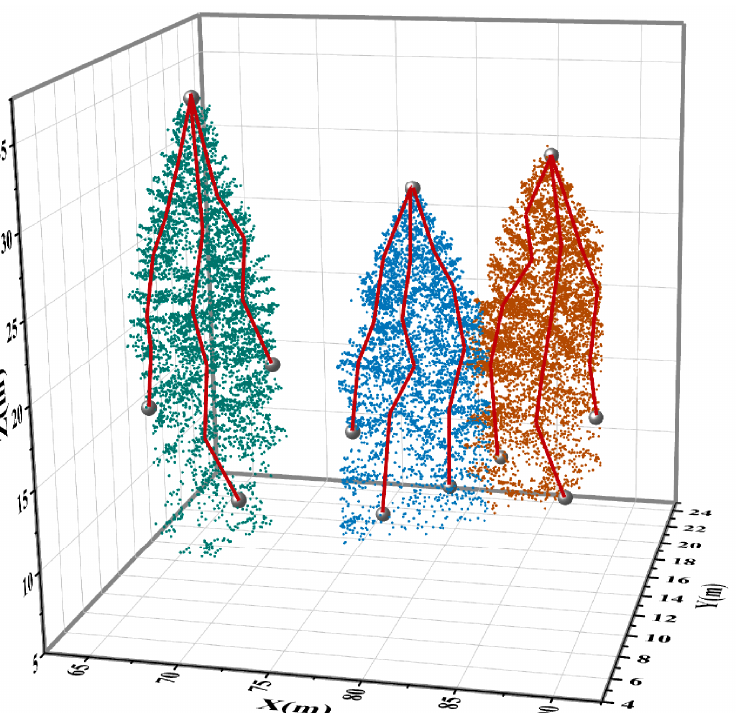
Figure 3. Stepwise iterative search for individual tree vertices at seed points in the MS algorithm.